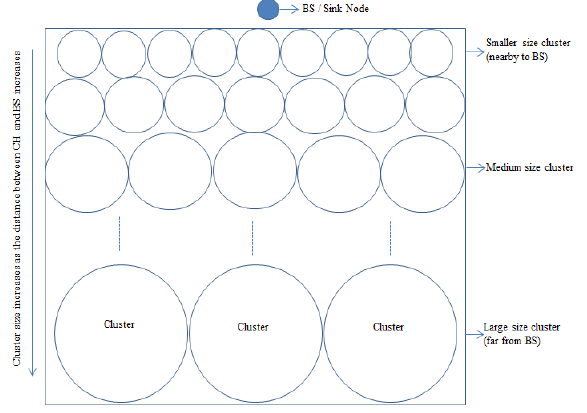
Figure 18. Architecture of unequal clustering in